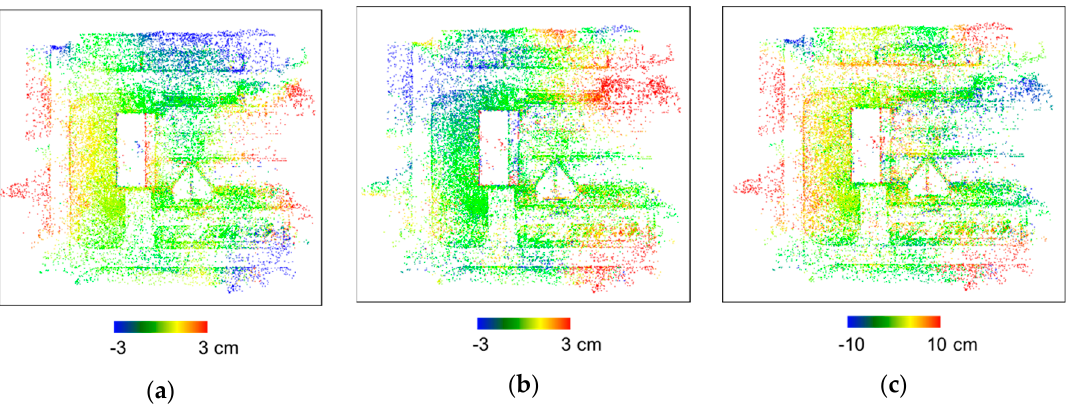
Figure 9. Top view of the sparse point cloud colored by ( a ) X discrepancy, ( b ) Y discrepancy, and ( c ) Z